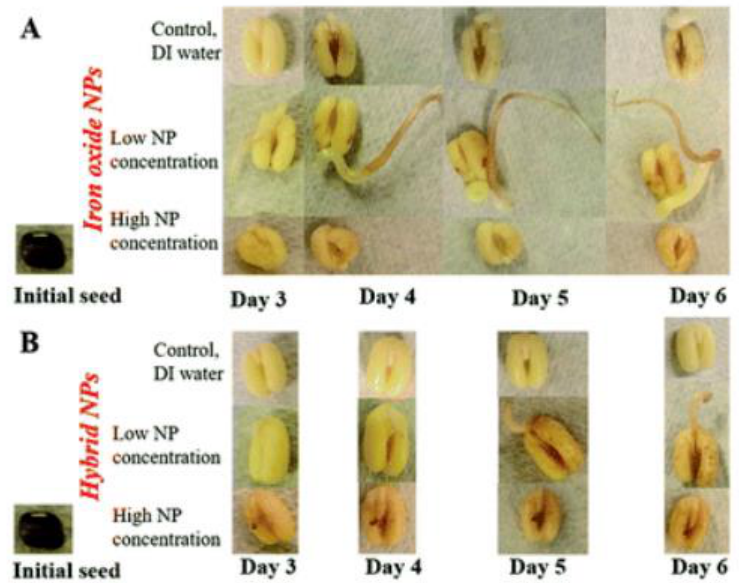
Figure 6. The growth of seedlings planted with nanoparticles at neutral pH: ( A ) legume root grown in the solution of iron oxide nanoparticles; ( B ) legume root planted in platinum-functionalized nanoparticles. High nanoparticle concentration = 27.7 mg/L Fe; low nanoparticle concentration = 5.54 × 10 −3 mg/L Fe. Reprinted from [85]; Royal Society of Chemistry (Open Access under Creative Common Agreement).